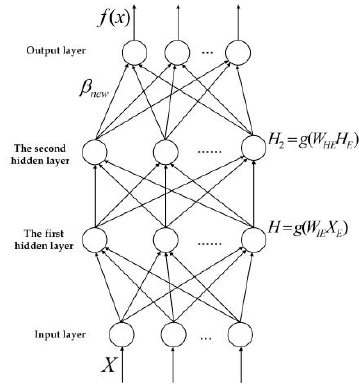
Figure 3. Network structure of TELM.